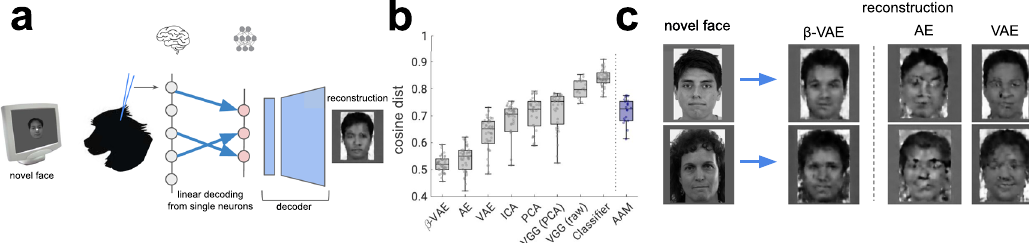
Fig. 7 Reconstructing novel faces from single neurons. a Responses of 159 neurons (grey circles) in face-patch area AM were recorded while two primates viewed 62 novel faces. One-to-one match was found between each model unit (pink circles) and a corresponding single neuron. Linear regression (blue arrow) was used to decode the responses of each individual model latent unit (pink circles) from the activations of its corresponding single neuron. The pre-trained model decoder was used to reconstruct the novel face. Face image reproduced with permission from Chang et al. 6 . b Cosine distance between real standardised latent unit responses and those decoded from single neurons are signi fi cantly smaller for β -VAE compared to baseline models and the “ gold standard ” provided by the AAM model (all p < 0.05, single-sided Welsch ’ s t -test; AE p = 0.0195, VAE p = 1.0596 e – 14, PCA p = 4.0370 e – 25, ICA p = 1.5758 e – 12, VGG (PCA) p = 5.0467 e – 24, Classi fi er p = 0.0, AAM p = 2.3216 e – 14, VGG (raw) p = 4.8840 e – 20). Circles, median cosine distance per model ( β -VAE, n = 51; VGG (raw), n = 22; Classi fi er, n = 64; VAE, Variational AutoEncoder 36 , n = 50; AE, AutoEncoder 35 , n = 50; VGG (PCA) 32 , n = 41; PCA, n = 41; ICA, n = 50; AAM, active appearance model 3 , n = 21). Boxplot centre is median, box extends to 25th and 75th percentiles, whiskers extend to the most extreme data that are not considered outliers, outliers are plotted individually. Source data are provided as a Source Data fi le. c β -VAE can decode and reconstruct novel faces from 12 matching single neurons. The reconstructions are better than those from the closest baselines, AE and VAE, which required 30 and 27 neurons for decoding, respectively. The β -VAE instance was chosen to have the best disentanglement quality as measured by the UDR score; AE and VAE instances were chosen to have the highest reconstruction accuracy on the training dataset. Face images reproduced with permission from Ma et al. 53 and Phillips et al. 55